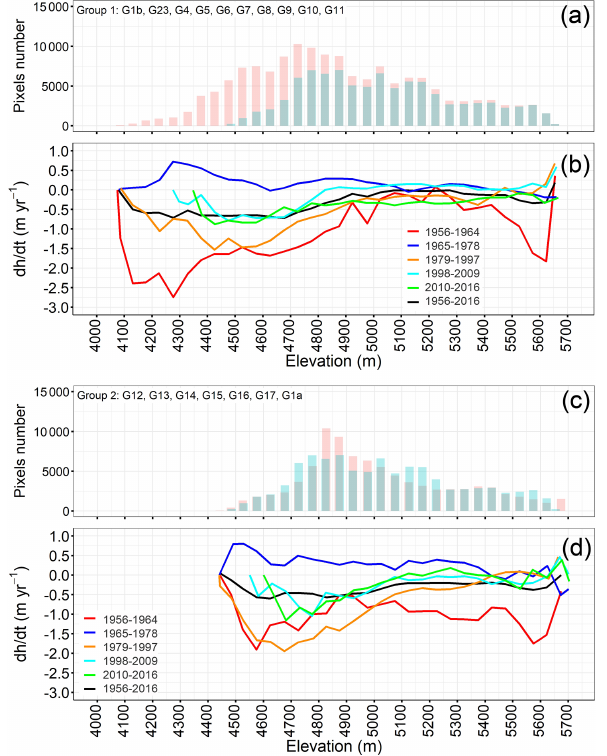
Figure 5. Antisana hypsometry in 1956 (red bars) and 2016 (cyan bars) and the elevation change rates for the study periods as a func- tion of the altitude of each group of glaciers: (a, b) Group I com- posed of glaciers exposed to Amazon fluxes and (c, d) Group II composed of glaciers exposed to Pacific fluxes. The d h/ d t values are averaged over a 50m elevation